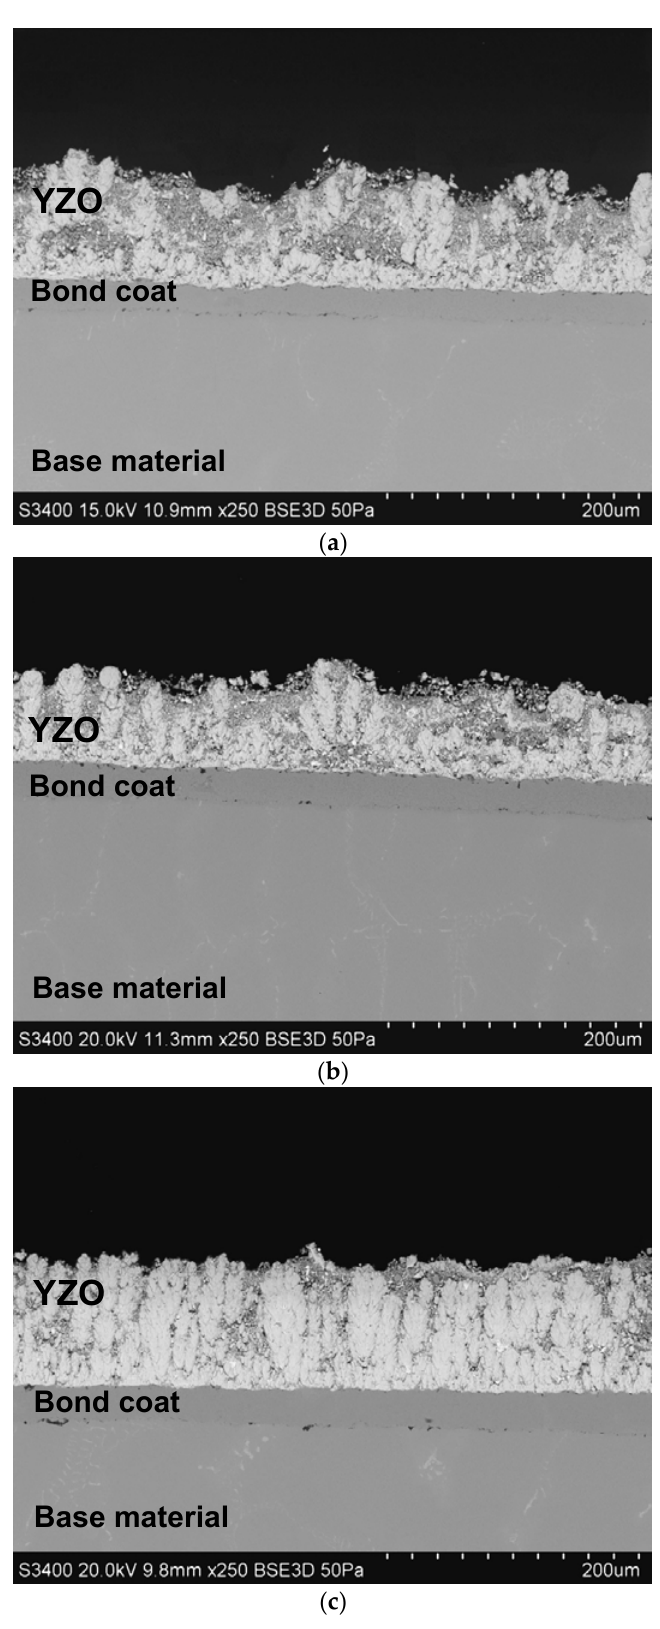
Figure 2. Microstructures of Yb 2 Zr 2 O 7 (GZO) layers made with different power current values: ( a ) YZO-1800 A, ( b ) YZO-2000 A, ( c ) YZO-2200 A.